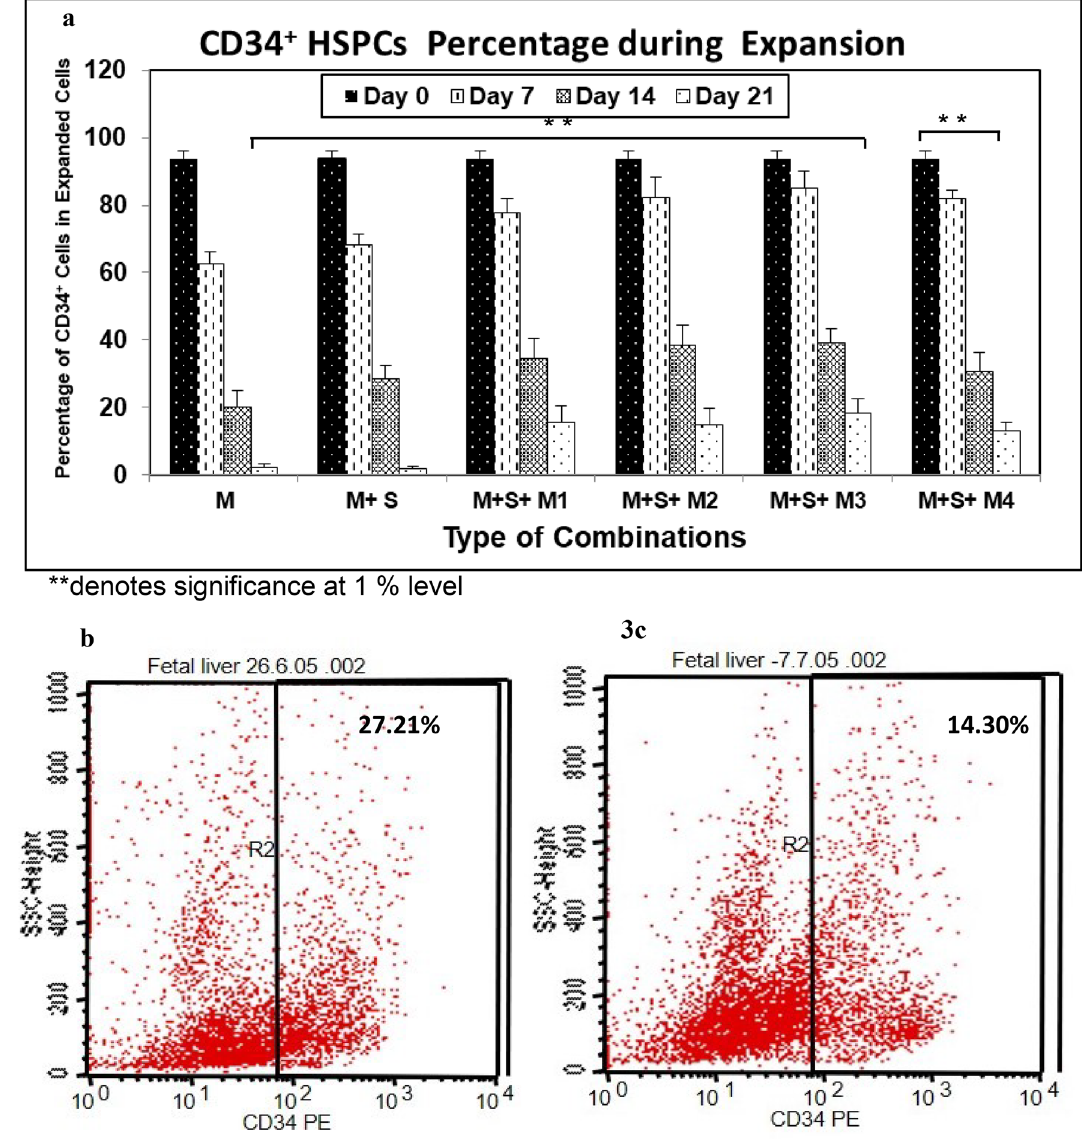
Figure 3. Percentage fetal liver CD34 + HSPCs cells during 21 days of expansion: CD34 expression of in vitro expanded cells from day 0–21 done through flowcytometry. Mean cell percentage is indicated (n = 5) with SEM ( a ). Statistical significance among different combinations as well as days was analyzed via ANOVA and is depicted with asterisks (*). double (**) asterisks indicate P ≤ 0.01. ( b ) Representative image of immunophenotyping of CD34 antigen from in vitro expanded cells using M + S + M4 media and cytokines combination at Day 14 ( b ) and Day 21( c ) done through